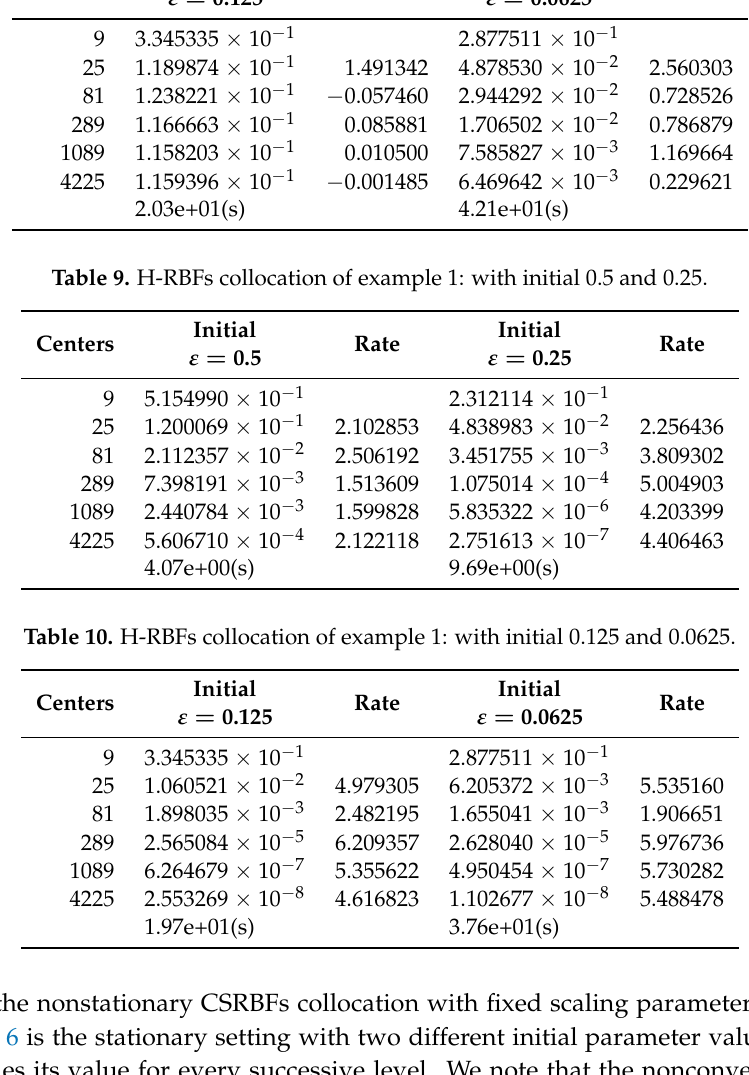
Table 5 is the nonstationary CSRBFs collocation with fixed scaling parameters of ε = 0.5 and ε = 0.25. Table 6 is the stationary setting with two different initial parameter values, 0.5 and